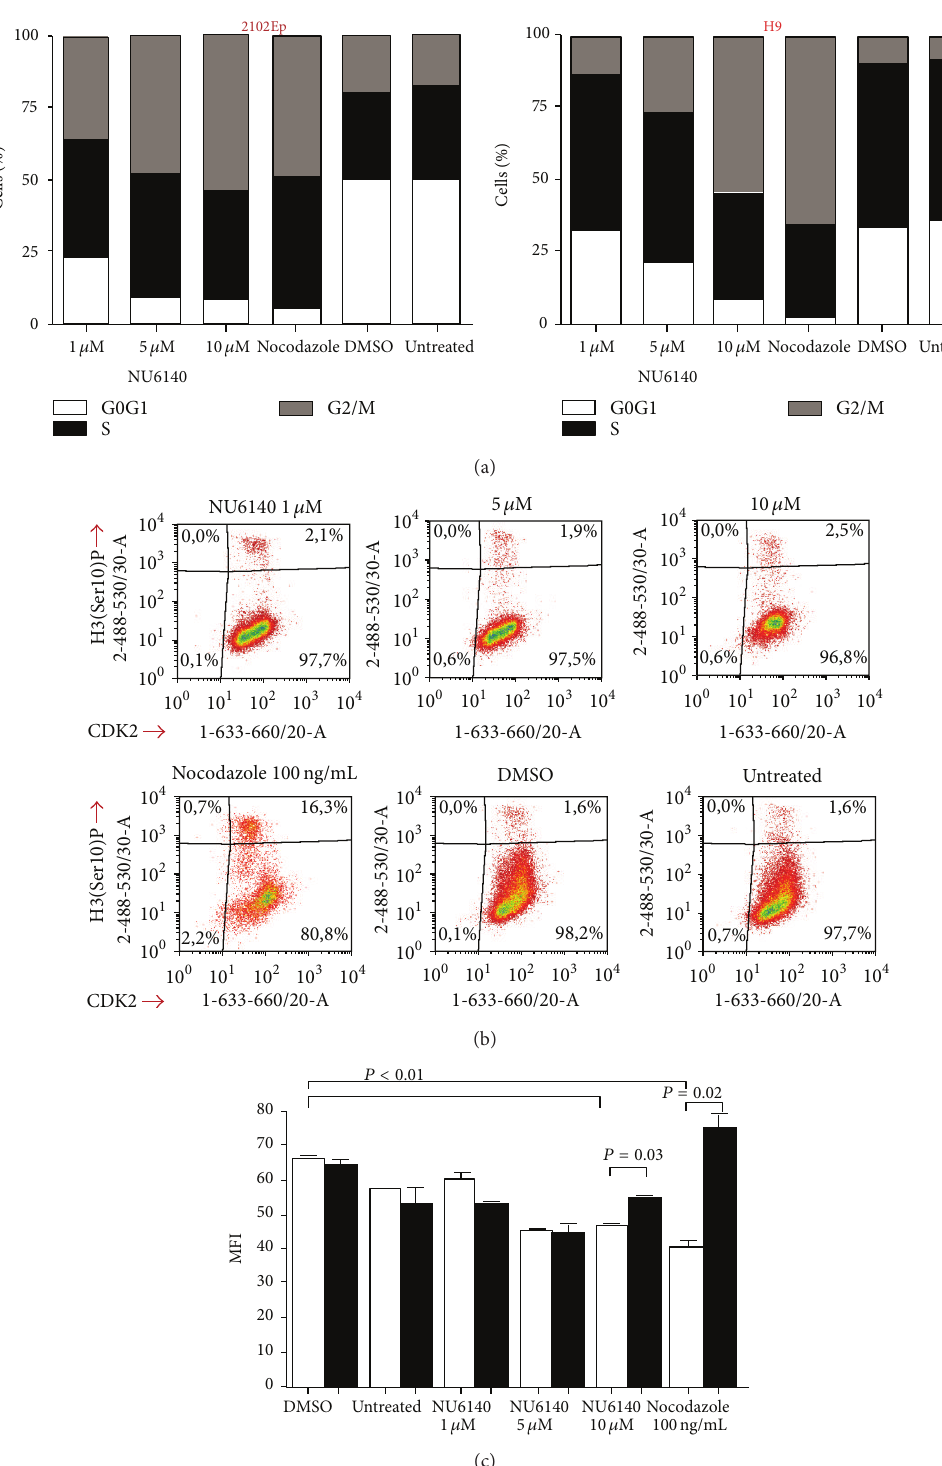
Figure 3: CDK2 inhibitor NU6140 accumulates hES and hEC cells in the G2 phase and nocodazole accumulates cells in the G2/M phase of the cell cycle. Changes in the cell cycle distribution of hES (H9 cells) and hEC (2102Ep cells) cells treated with NU6140, nocodazole, DMSO, or maintenance medium (untreated cells). (a) Distribution of cells within different cell cycle phases. Ethanol fixed and propidium iodide stained cells were analysed by flow cytometry and cell cycle analysis was performed by using ModFit software. (b) Histone 3 phosphorylation at Serine 10 was done using flow cytometric analysis. Results are representative of two independent experiments and shown as density plots. (c) Mean fluorescence intensity (MFI) of CDK2+H3P+ (white empty bar) and CDK2+H3P − (black filled bar) populations as gated in the last density plot (CDK2 expression versus H3 phosphorylation). Results are shown as mean ± SEM ( 𝑛 = 4